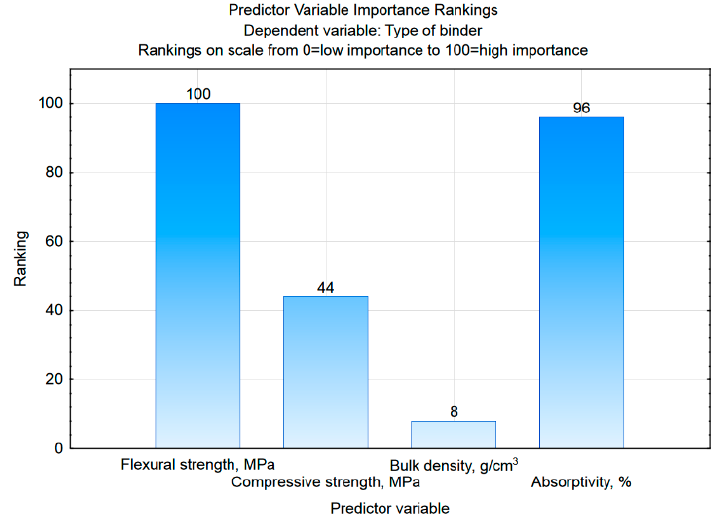
Figure 9. The results of the assessment of the importance of predictors in the classification tree method.